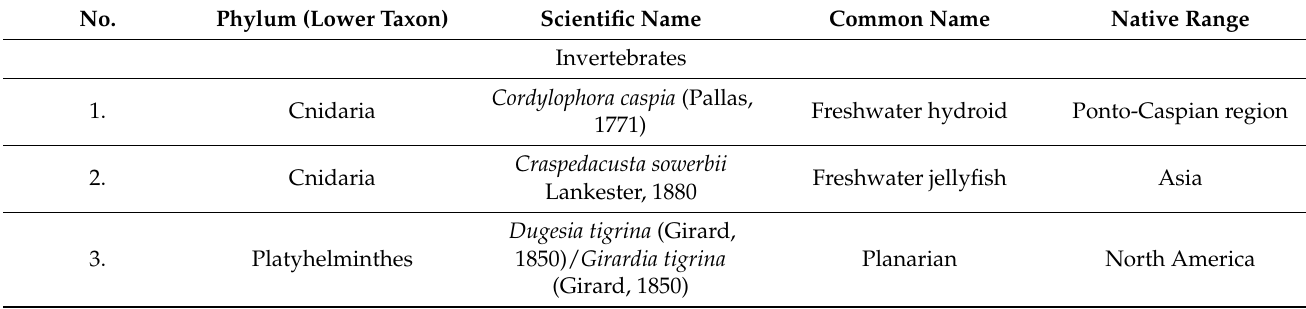
Table 1. List of the invasive alien species (aquatic invertebrates and fish) of concern to the Danube River Basin. *—The species is currently listed as IAS of EU concern